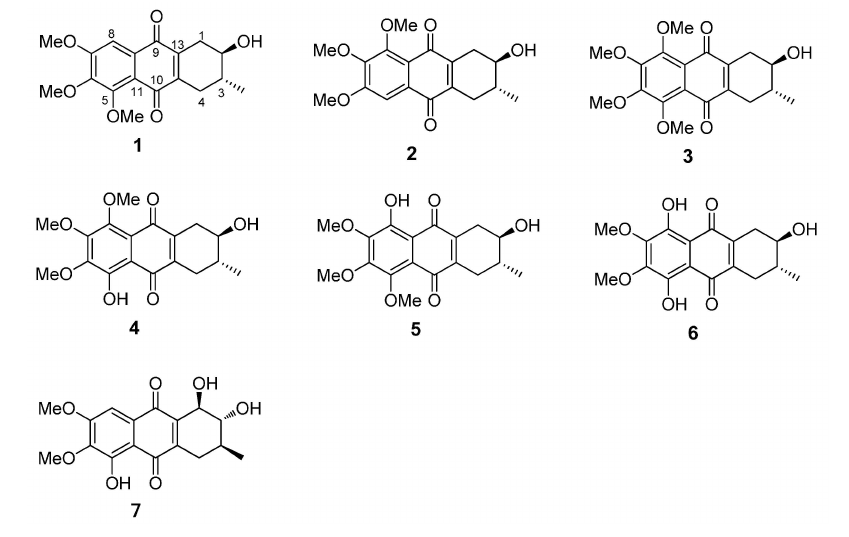
Figure 1. Chemical structure of compounds 1 – 7 .